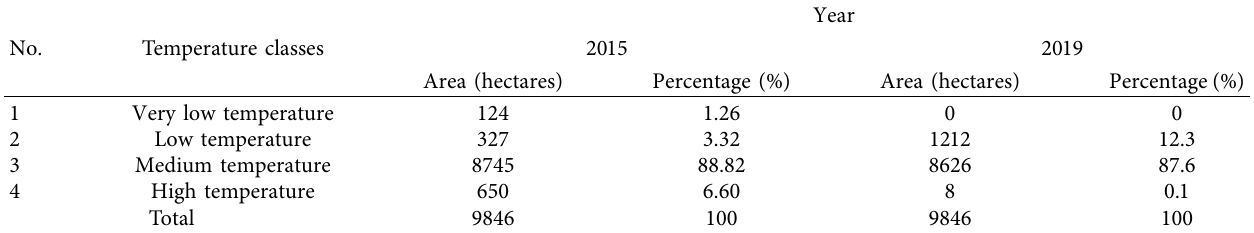
Table 4: Area of surface temperature classifcation in Banjarmasin City in 2015 and 2019.